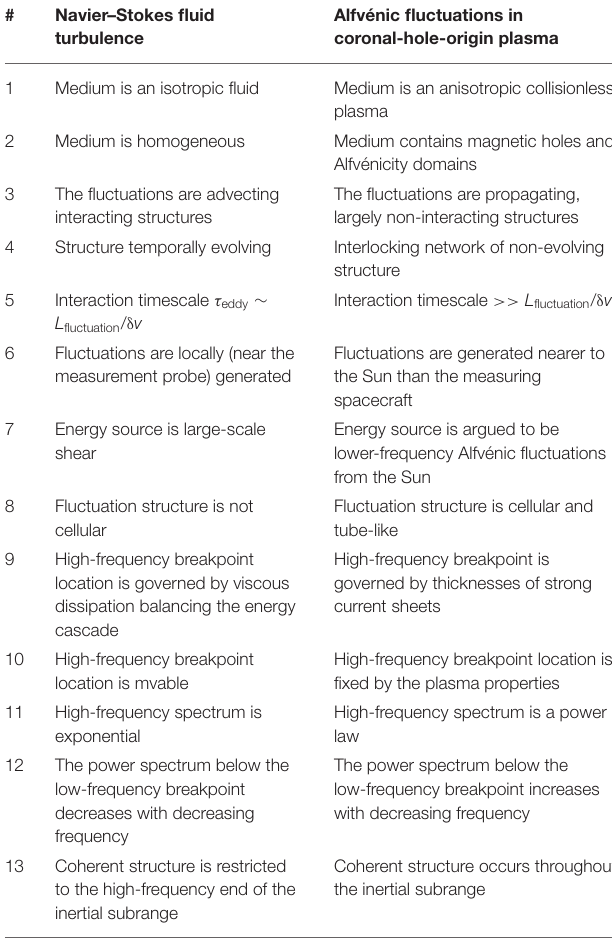
TABLE 2 | A summary of differences between the Navier–Stokes turbulence in the wind tunnel and the Alfvénic fluctuations of the fast solar